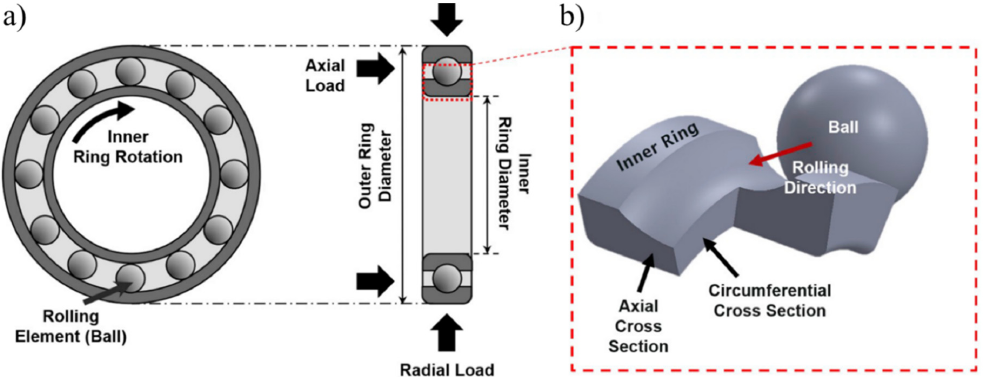
Figure 1. ( a ) Schematic of a deep groove ball bearing subjected to axial and radial load; ( b ) axial and circumferential cross-section of the inner ring is demonstrated [2].